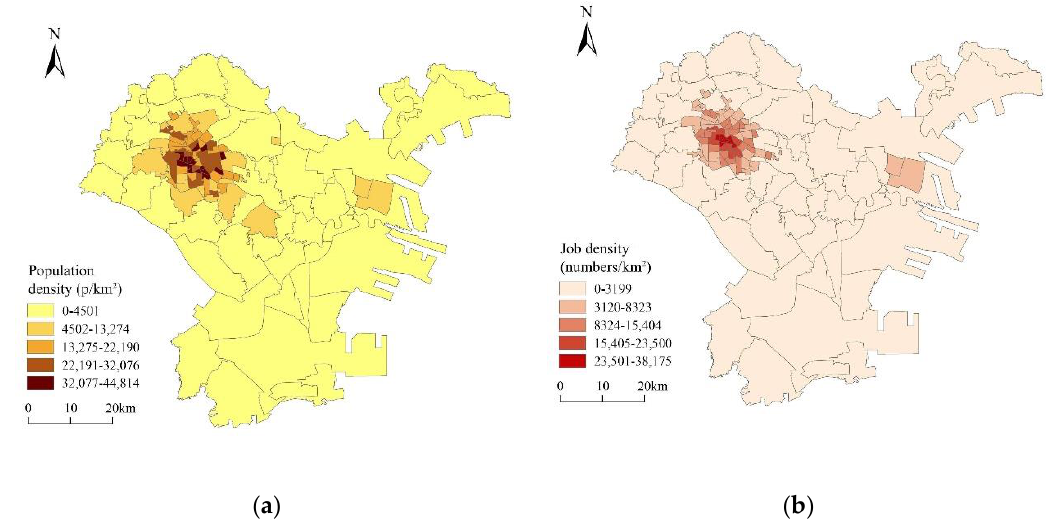
Figure 2. ( a ) Population density in Tianjin metropolitan area; ( b ) Job density in Tianjin metropolitan area.